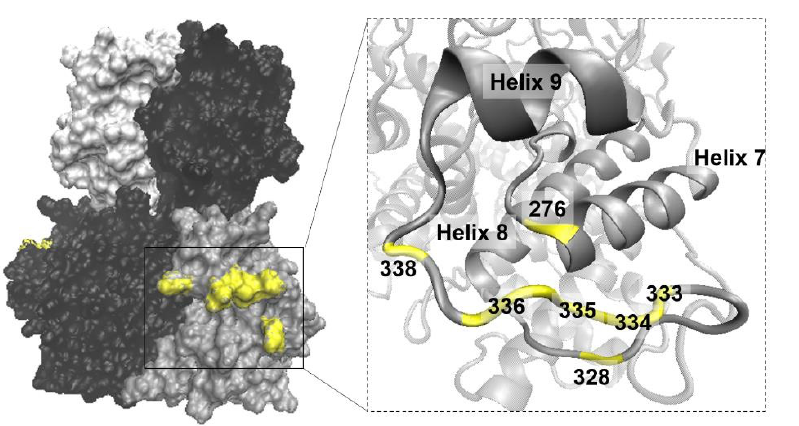
Figure 5. Three-dimensional analysis of the position and secondary structure of the AHSV VP7 “276” region. The AHSV VP7 trimer model is depicted on the left with monomers coloured in grey, black, or white. Amino acids targeted for substitution (276, 328, 333 – 336, and 338) are highlighted in yellow. The “276” region is magnified on the right , depicting the secondary structure of the region, and amino acid positions are illustrated and highlighted in yellow.